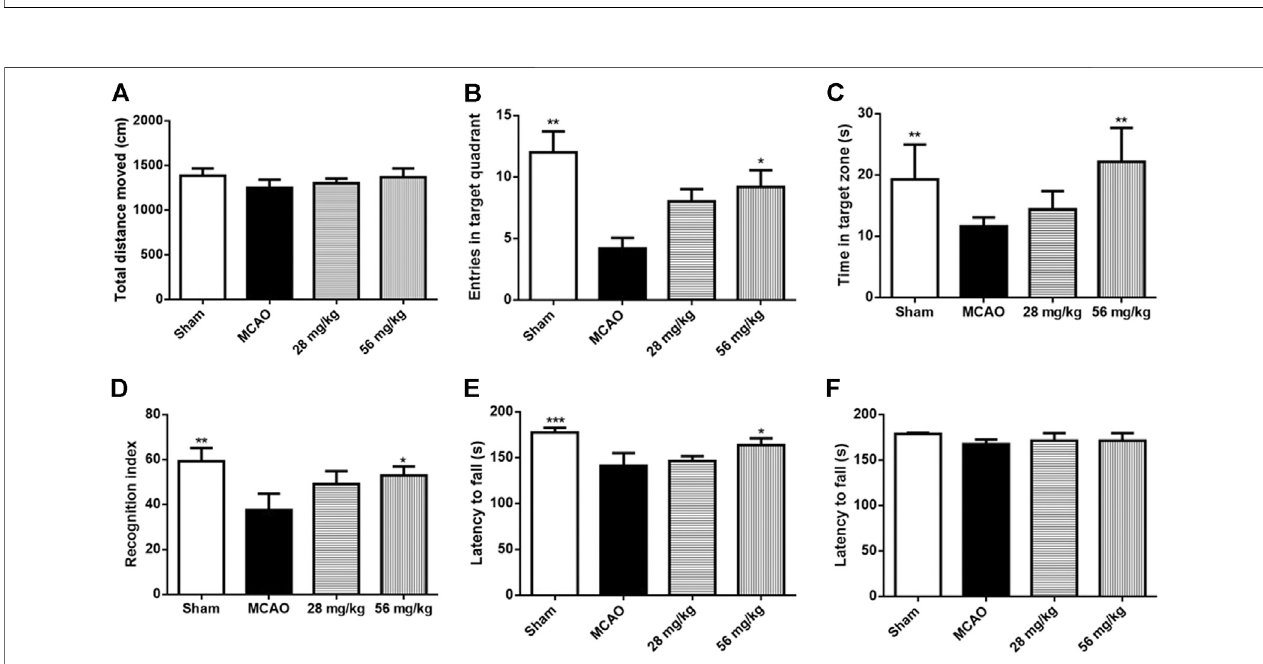
FIGURE4| SBPImprovedBehaviouralEffectsonLocomotorandAnxietyinRats14 daysafterIschemia-ReperfusionBrainInjury. (A) representativeopen fi eldtest path (B) Entries in the target quadrant during the probe test. (C) Time stay in target quadrant during open fi eld test. (D) Recognition index from noval object recognition. (E) Time to stay at rotarod at day 7. (F) Time to stay at rotarod at day 14. Data are expressed as mean ± SEM, n (cid:2) 9: * p < 0.05, ** p < 0.01, *** p < 0.001 compared to MCAO.